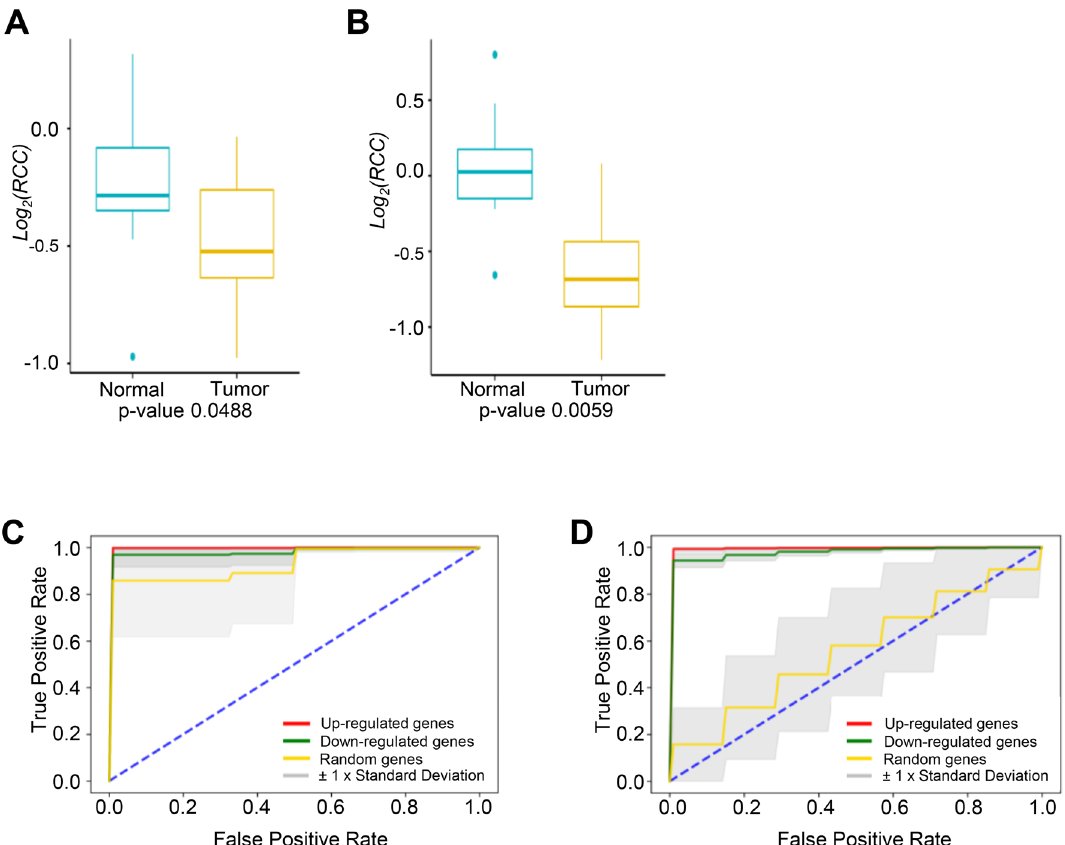
Figure 5. ( A ) The log ratio of closeness centrality (RCC) between normal and tumor samples for the proposed potential biomarkers in Esophageal cancer. ( B ) The log ratio of closeness centrality (RCC) between normal and tumor samples for the proposed potential biomarkers in Stomach cancer. ( C ) Comparison of ROC curves with features of the leading up-regulated genes, the leading down-regulated genes and the random selected genes for classification of tumor and normal samples in esophageal cancer. The dashed blue line in the diagonal presents the ROC curve of a random predictor, which has an AUC of 0.5 and can be used as the baseline to validate the effectiveness of our models. The mean AUC scores of the SVM models based on the up-regulated genes and the down-regulated genes are 0.9941 (standard deviation: 0.0031) and 0.9788 (standard deviation: 0.0265), respectively. The mean AUC of the comparison group, which uses the random selected genes, has the lowest score 0.9280 (standard deviation: 0.1137). ( D ) Comparison of ROC curves with features of the leading up-regulated genes, the leading down-regulated genes and the random selected genes for classification of tumor and normal samples in stomach. The dashed blue line in the diagonal presents the ROC curve of a random predictor, which has an AUC of 0.5 and can be used as the baseline to validate the effectiveness of our models. The mean AUC scores of the SVM models based on the up-regulated genes and the down-regulated genes are 0.9924 (standard deviation: 0.0038) and 0.9770 (standard deviation: 0.0114), respectively. The mean AUC of the comparison group, which uses the random selected genes, has the lowest score 0.5603 (standard deviation: